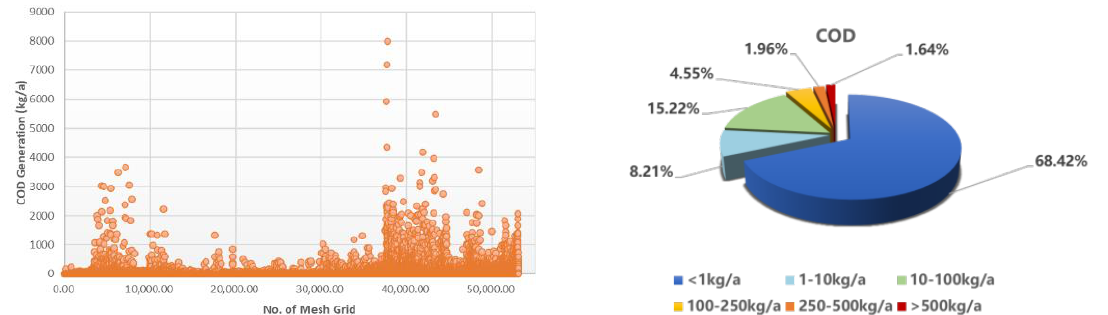
Figure 14. Classification diagram of COD generation in sewage.